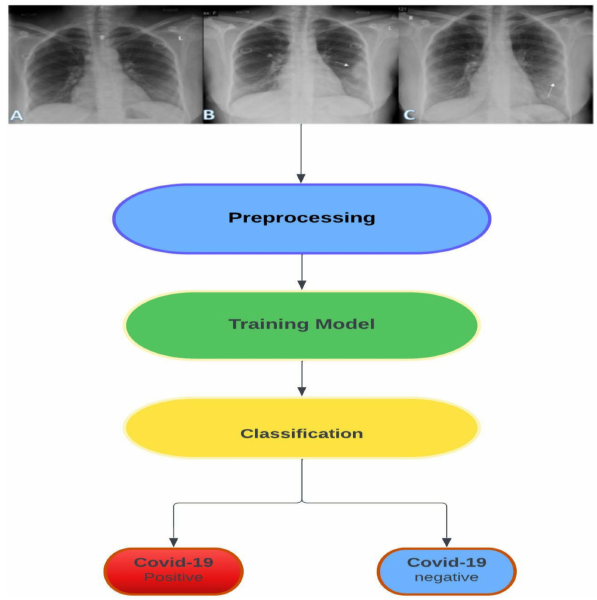
Figure 10. The block diagram of the proposed COVID-19 detection algorithm from X-ray images. The letters ( A – C ) are used to show different samples of x-ray